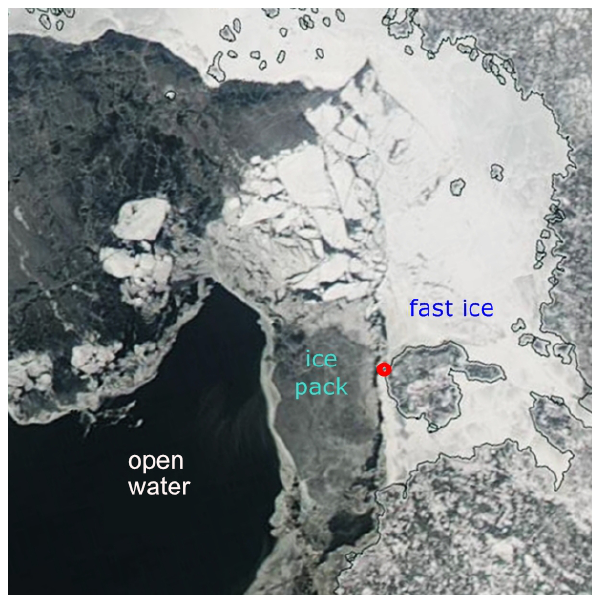
Figure 2. Sea ice conditions in the inner parts of the Bay of Bothnia on 28 February 2020 (Day 1 of the campaign): MODIS Aqua image with marked fast ice, ice pack, and open water areas. The red dot shows the location of the Marjaniemi harbor.